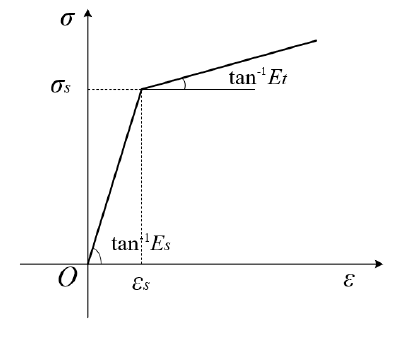
Figure 2. Stress–strain curve of steel.